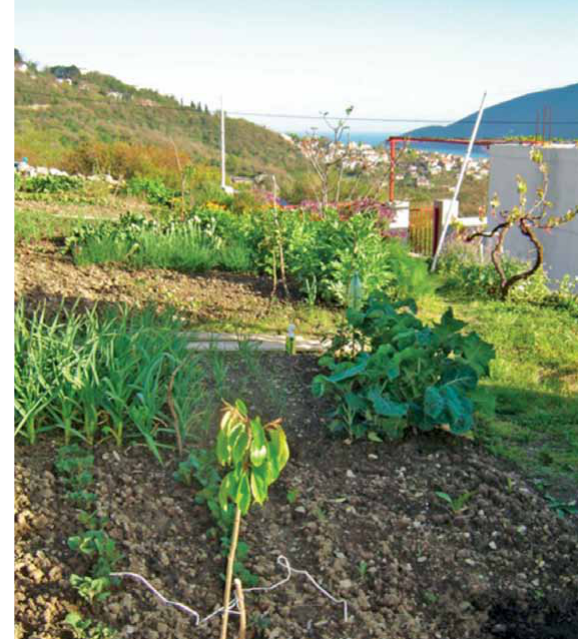
fig. 13. local residence fig. 14. House